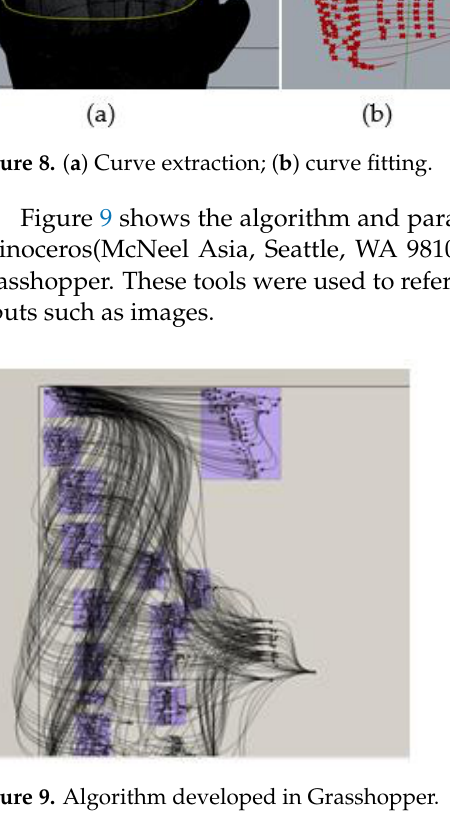
Figure 9. Algorithm developed in Grasshopper.